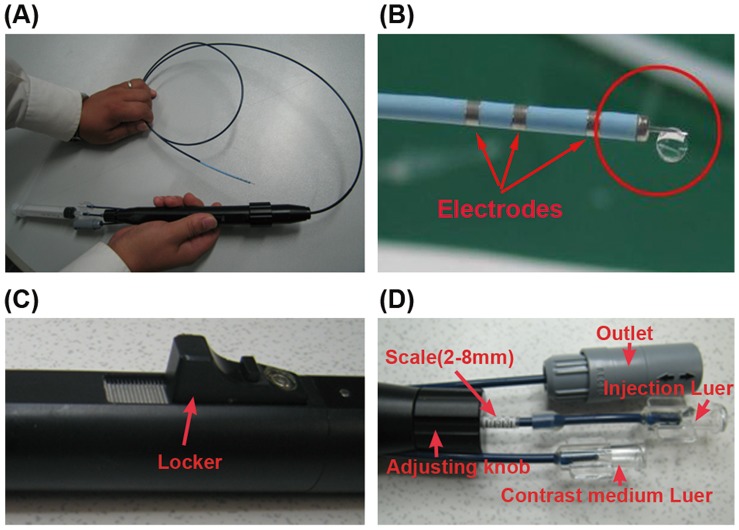
The intramyocardial injection system.(A)The injection device comprises a catheter and handle. The catheter involves in mapping and injection functions. (B) The distal end of the catheter is equipped with tip and ring electrodes, a location sensor and a 27 guage needle designed for transendocardial injection. The red circle marks out a drop of saline injected through the needle tip. (C) The locker fixed the needle whose length was selected. (D) The adjusting knob controls the length of needle into myocardium. Two Luer fit for connection to an auto-syringe pump and a syringe of contrast medium, respectively.